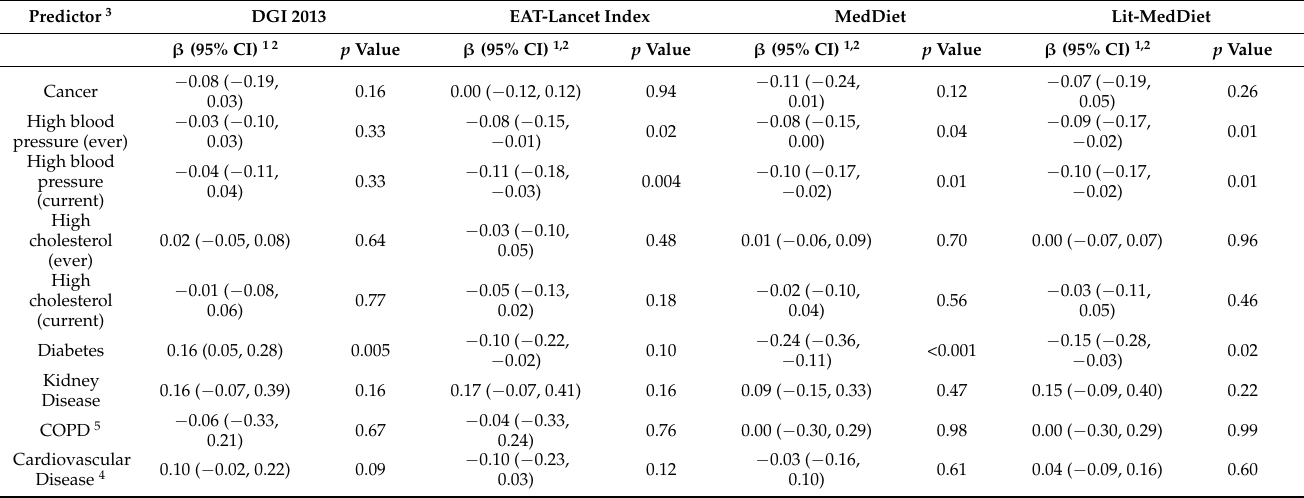
Table 4. Model three beta coefficient estimates of the EAT-Lancet Index, Dietary Guideline Index 2013 (DGI-2013), Mediterranean Diet Index (MedDiet) and the Literature-Based Mediterranean Diet